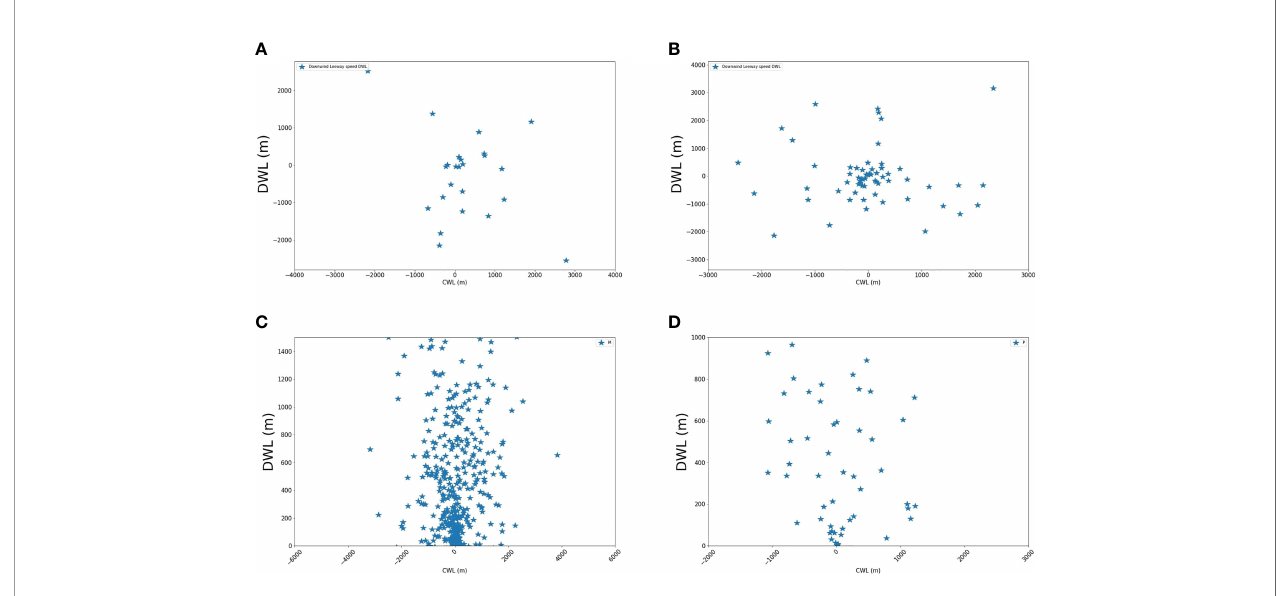
FIGURE 12 | CWL-DWL trajectory plots for (A) Pelican 1 in m (B) Pelican 2 in m, (C) PIW-1 in m. (D) PIW 2 in